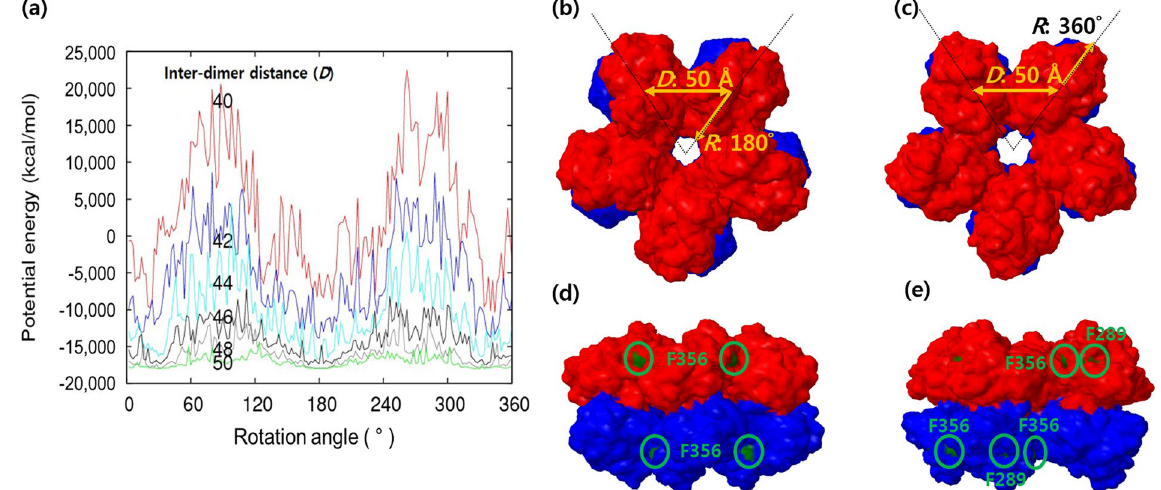
Figure 5. MDH decamer structure ( a ) Energy profile changes by rotation angle ( R: x-axis) and inter-dimer distance ( D: lines with different colours). ( b ) Top and side views of the decamer structure with ( R, D ) = (180°, 50 Å). ( c ) Top and side views of the decamer structure with ( R, D ) = (360°, 50 Å). The exposed mutation positions are shown in green and accompanied by residue